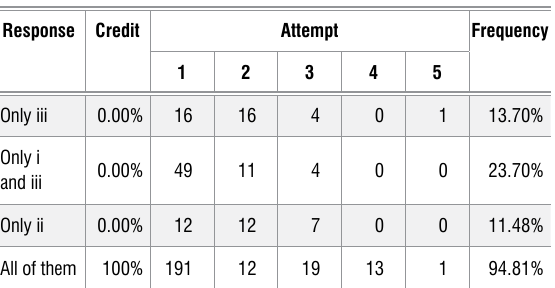
Analysis of student responses for Question 5 ( n =